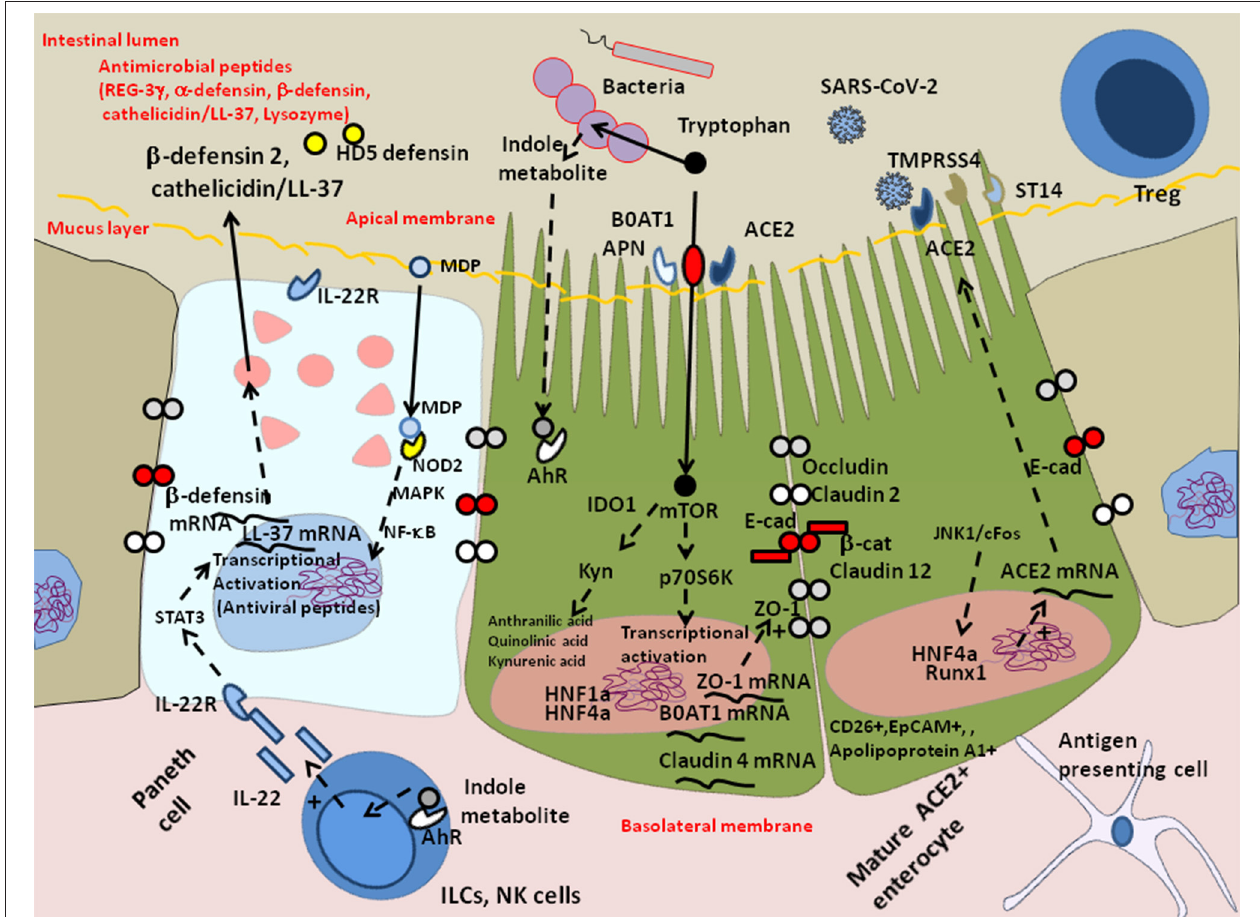
FIGURE 5 | Interaction between the Tryptophan receptor channel B 0 AT1 and ACE2 at the surface of enterocytes. The main role of enterocytes is to ensure the absorption of nutriments. ACE2, expressed by enterocytes is necessary for the surface expression of the amino acid transporter B 0 AT1 in the intestinal epithelium. Tryptophan (Trp) is an essential amino acid obtained from food and whose assimilation depends on B 0 AT1. It mediates crosstalk between the intestinal mucosal immune system and the microbiota. Trp directly activates the mammalian target of rapamycin (mTOR) pathway and enhances tight junctions though increased expression of cell adhesion molecules Zonula occludens (ZO-1, ZO-2) and likely E-Cad. In addition, Trp promotes the IL-22/IL-22R-mediated expression of endogenous AMPs, such as β -defensin and LL-37 by Paneth cells, which in turn influence the composition of the intestinal microbiota. It is worth noting that HD5 binds ACE2. It can be hypothesized that following infection with SARS-CoV-2, tryptophan cannot get properly absorbed due to the reduced expression or the absence of ACE2/ B 0 AT1, leading to aberrant secretions of AMPs, and altered microbiota (decreased microbiota diversity), which confers susceptibility to intestinal inflammation. Symbols: ( + ) means activation; (–) means: